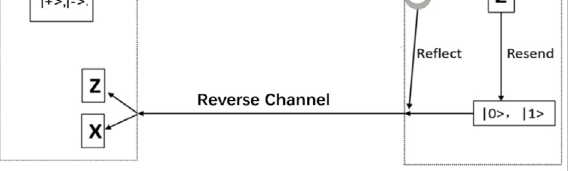
FIGURE 3 The typical setup of a four-state SOKD protocol. The fi gure is from [61], Alice prepares and sends one of the four states with uniform probability, and Bob chooses either to Measure and Resend or to Re fl ect the incoming qubit, and Alice measures thereturningqubitonthesamebasissheinitiallyusedtoprepareit (Z or